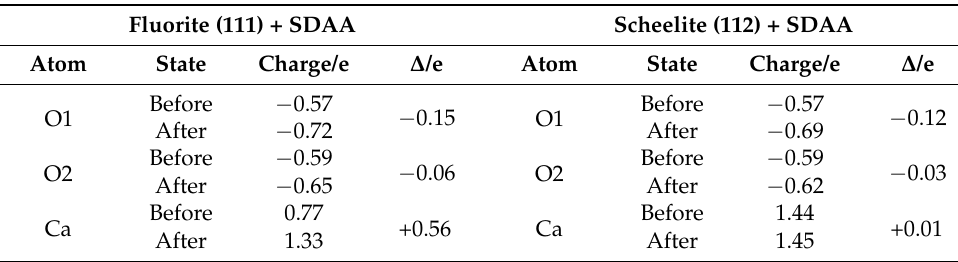
Figure 8. ( a ) Adsorption configuration of SDAA on fluorite (111) surface and ( b ) adsorption configu- ration of SDAA on scheelite (112) surface. Table 2. Mulliken charge population of active O and Ca atoms before and after SDAA reacting with fluorite and